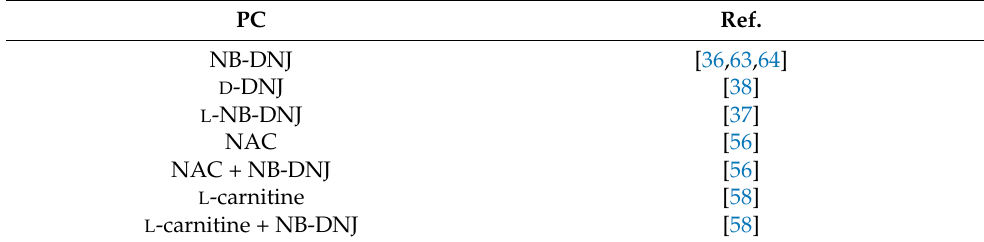
Table 3. PC candidates for combination therapy with ERT. PC